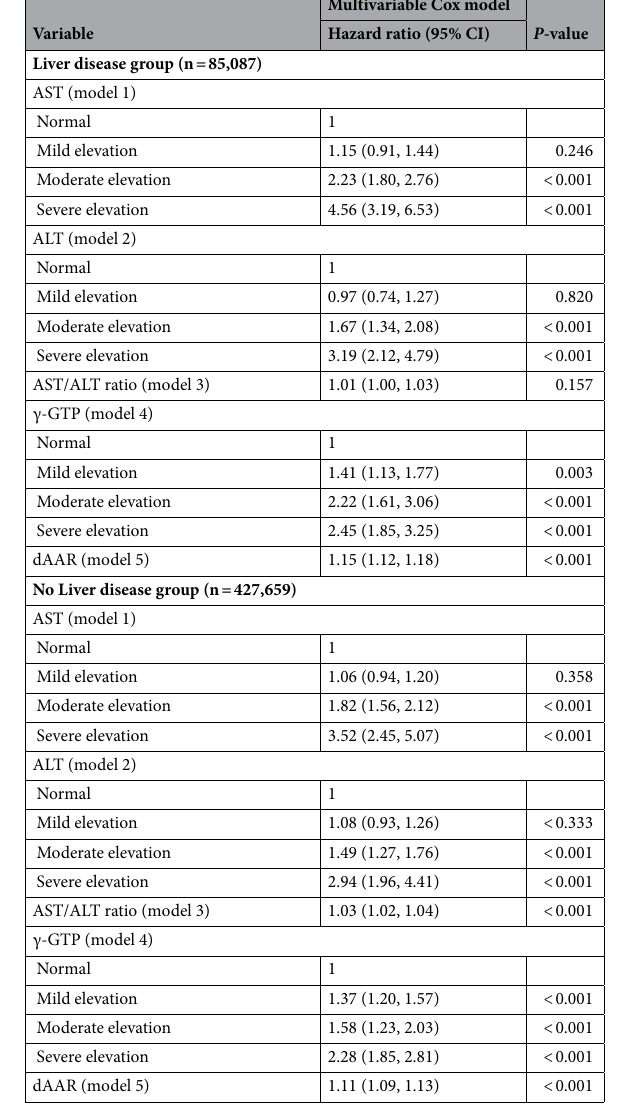
Table 3. Subgroup analyses according to comorbid of liver disease. CI, confidence interval; AST, aspartate transaminase; ALT, alanine aminotransferase; γ-GTP, γ-glutamyl